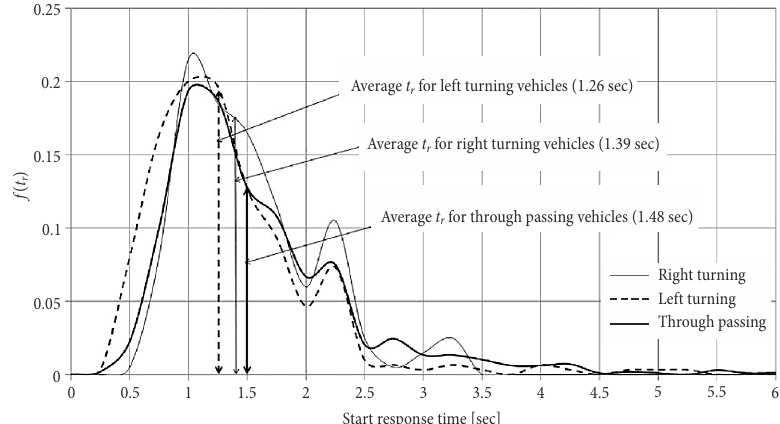
Fig. 4. Probability distribution plots of left turning, right turning and through passing drivers’ response times